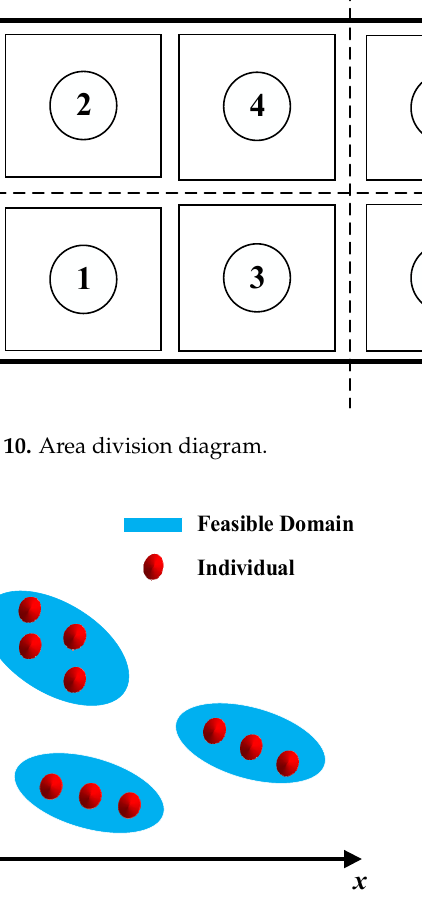
Figure 11. Schematic diagram of the population distribution.